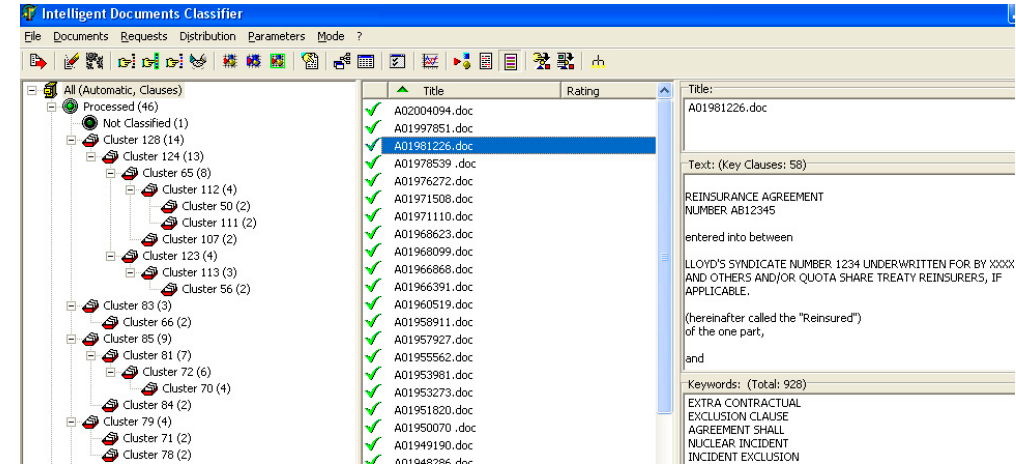
Figure 9. Clusters of documents for car insurance.